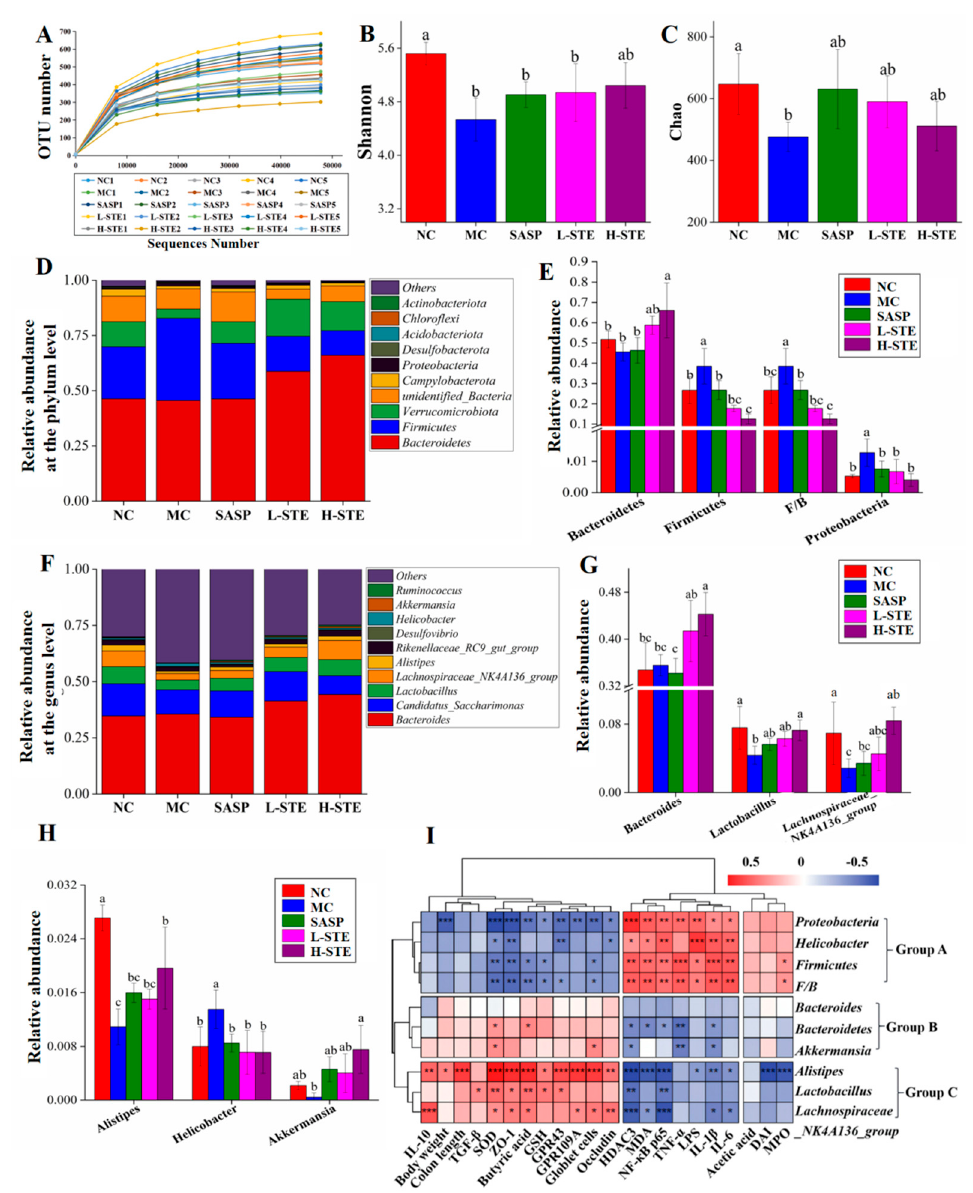
Figure 6. Effects of STE on the composition and abundance of gut microbiota in DSS-induced ulcerative colitis mice. ( A ) The number of observed OTUs. ( B ) Shannon index. ( C ) Chao index. ( D ) Distribution of gut microbiota at the phylum level. ( E ) Intestinal microbiota with significant differences at the phylum level. ( F ) Distribution of gut microbiota at the genus level. ( G , H ) Intestinal microbiota with significant differences at the genus level. ( I ) Correlation between the significantly changed gut microbiota and biochemical parameters (* p < 0.05, ** p < 0.01, and *** p < 0.001). Data are expressed as the mean ± the SD ( n = 5). Bars with different lowercase letters indicate significant differences ( p < 0.05).